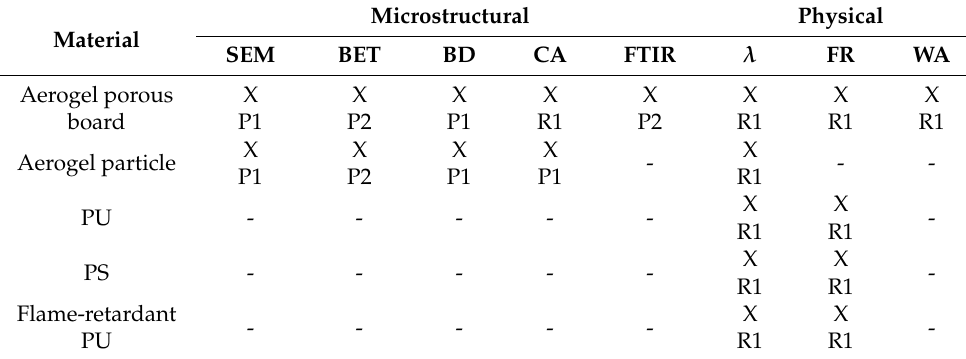
Table 1. Tests conducted for each